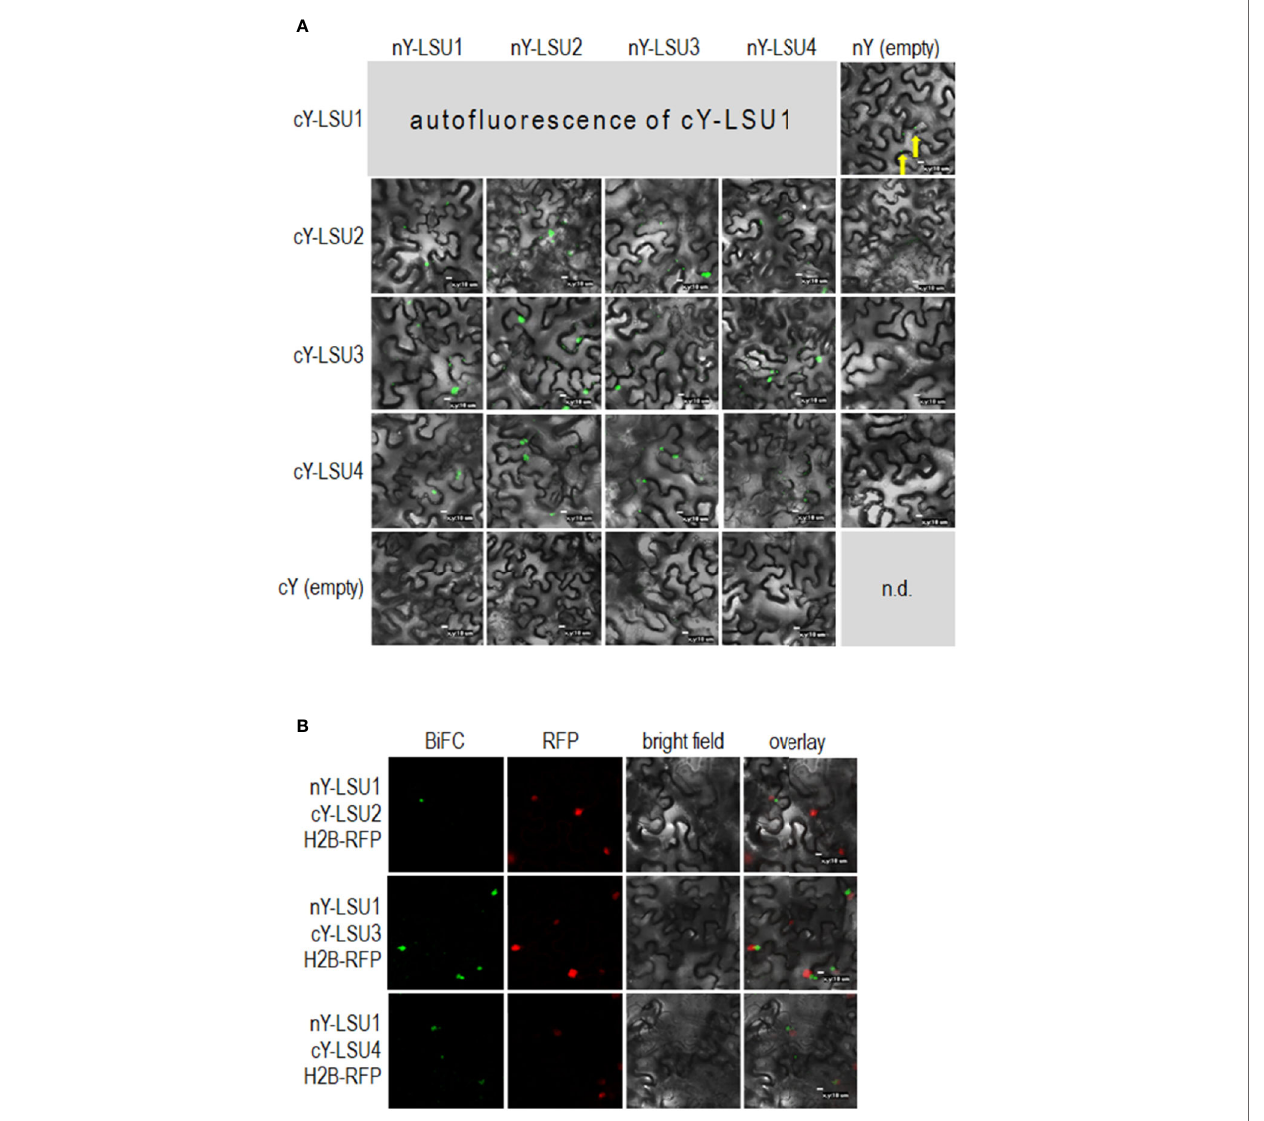
FIGURE 1 | Representative Bimolecular Fluorescence Complementation (BiFC; green spots) image of LSU – LSU pairs (A) and co-localization of BiFC for LSU1, with the recombinant nuclear H2B-RFP protein (red spots) (B) . cY and nY represent the C-terminal and N-terminal sections of YFP, respectively, fused to the indicated protein or present in empty vector. n.d, no data for this combination. The yellow arrows point to auto fl uorescence of cY-LSU1. The enlarged versions of the images presented are shown in Supplementary Figure 1